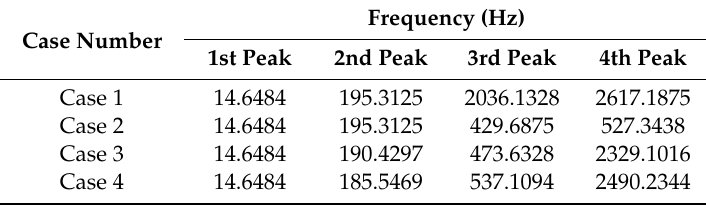
Table 2. Frequency values related to coherency losses for each inspected case.